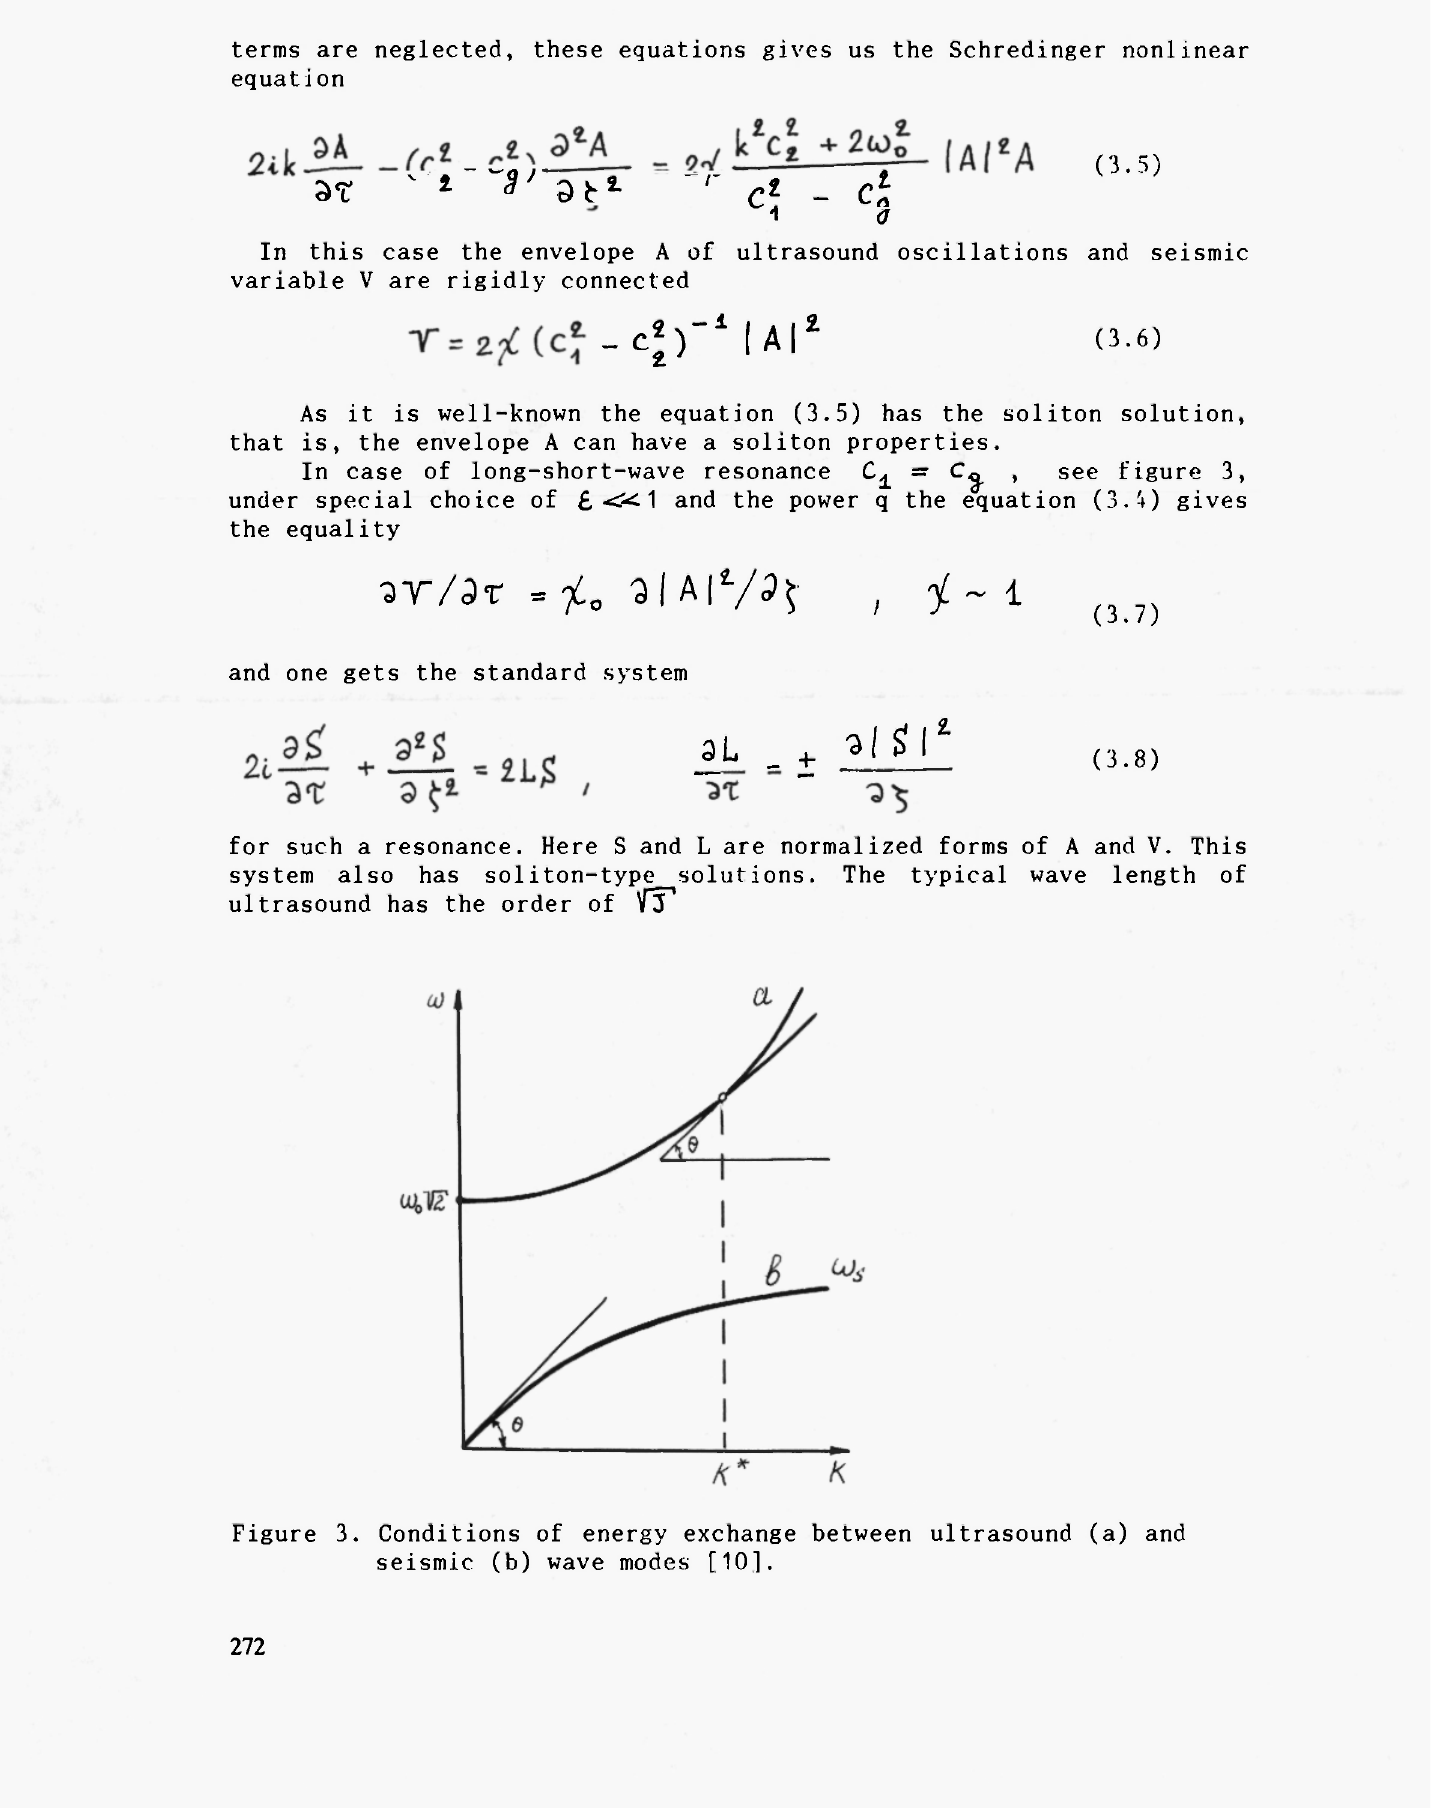
Figure 3. Conditions of energy exchange between ultrasound (a) and seismic (b) wave modes